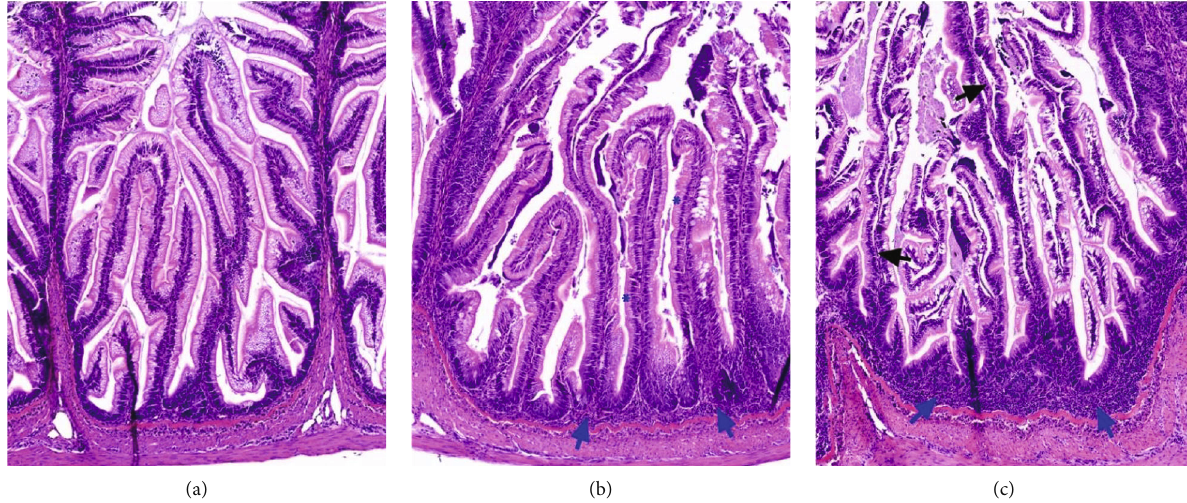
Figure 11: Representative images of the distal intestine mucosa showing the histology changes observed. (a) DI tissue with normal and healthy morphology, alongside; (b) DI mucosa with mild enteritis characterized by in fi ltration of the submucosal compartment (blue arrows) and some mild loss of enterocyte vacuolization (blue asterisks); and (c) DI mucosa with moderate enteritis with a higher level of in fi ltration of the submucosal compartment (blue arrows) and mild in fi ltration of the lamina propria (black arrows) but with no reduction in mucosal fold height or loss on enterocyte